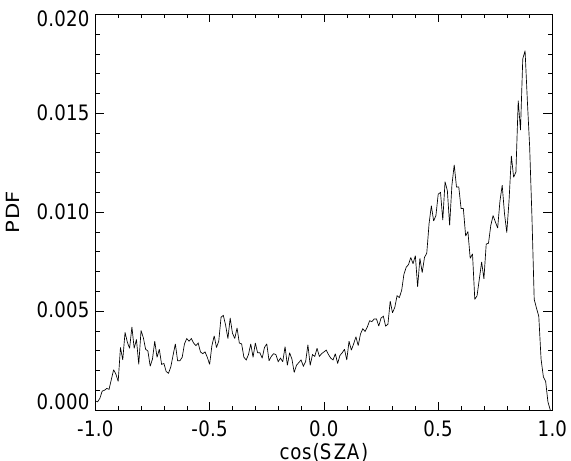
Figure 12. Radiative forcing (blue: LW, red: SW) vs. cosine of the solar zenith angle (SZA) corresponding to the contrails in the data